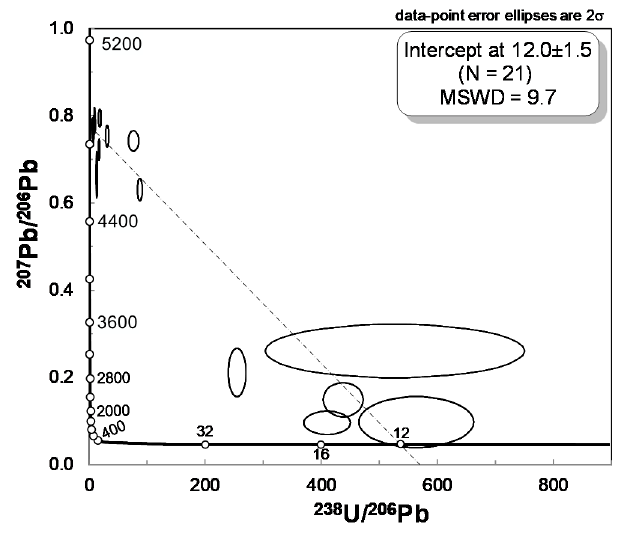
Figure 11. Tera–Wasserburg Concordia diagram based on the U–Pb LA–ICP–MS data for rutiles associated with ruby. The lower intercept age is shown in the legend.